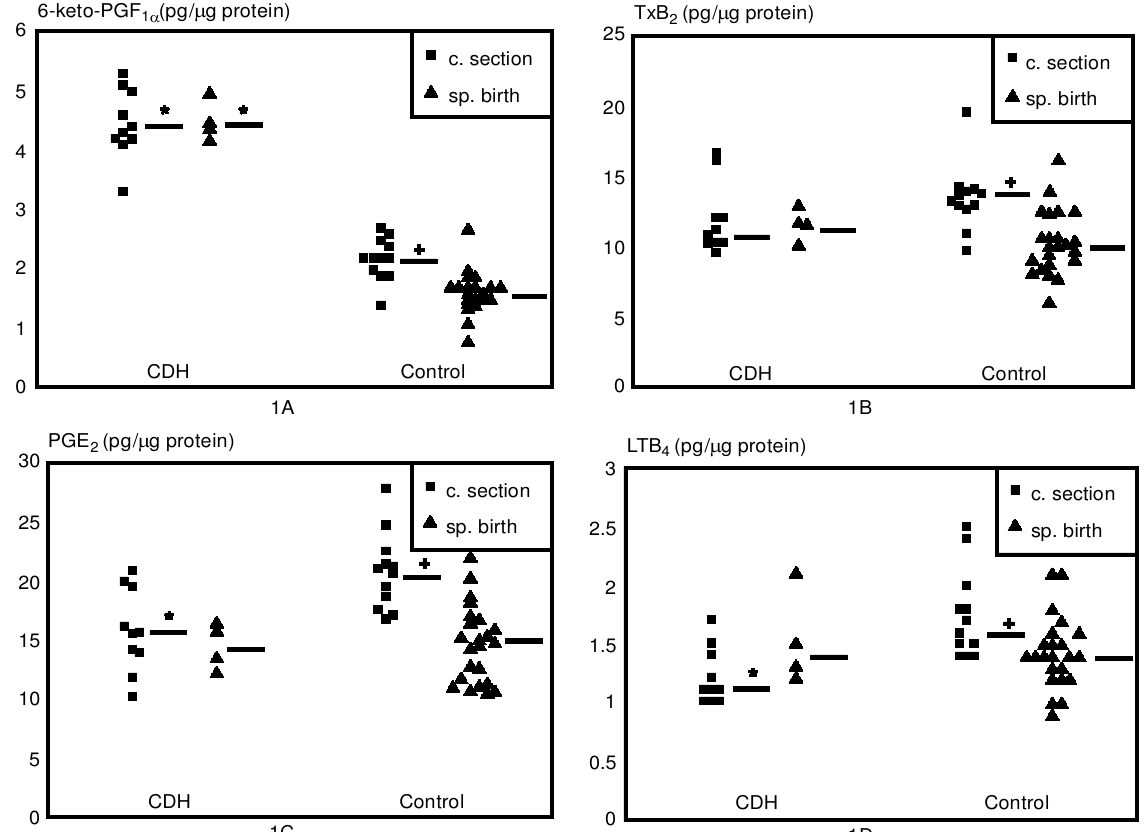
FIG. 1. Concentration of 6-keto-PGF 1 a (1A), TxB 2 (1B), PGE 2 (1C), and LTB 4 (1D) per m g protein in lung homogenates of rat pups with CDH and controls delivered by caesarean section (squares) or spontaneously born pups (triangles). Median is indicated for each group. Signi® cantly different from controls; similar mode of delivery; P , 0.01. Signi® cantly different from controls after spontaneous birth; P , 0.02.